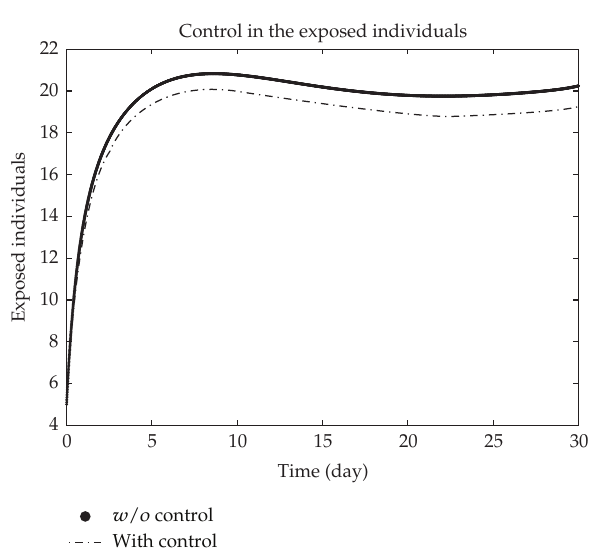
Figure 3: The plot represents the population of exposed class with and without control.